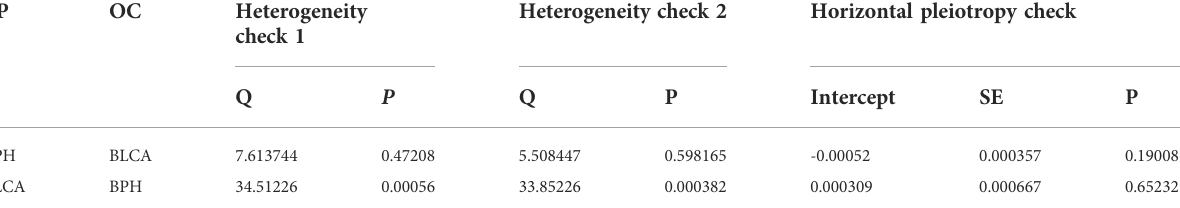
TABLE 4 Heterogeneity and horizontal pleiotropy check.